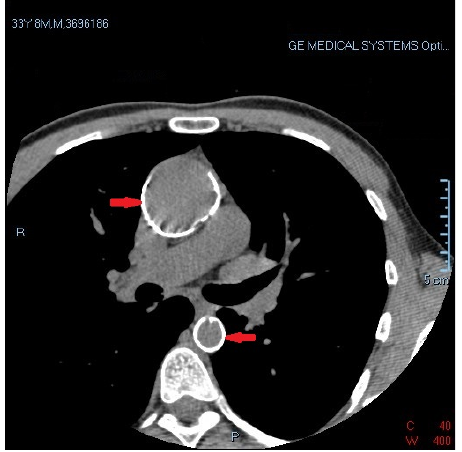
Figure 7. Computed tomography (CT) confirmed severe ascending and descending aortic calcification compatible with porcelain aorta.